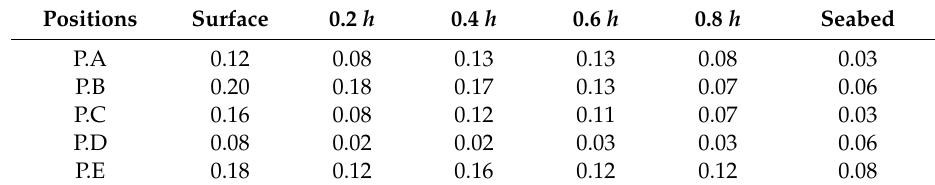
Table 1. Measured velocities at five test sites (P.A − P.E).